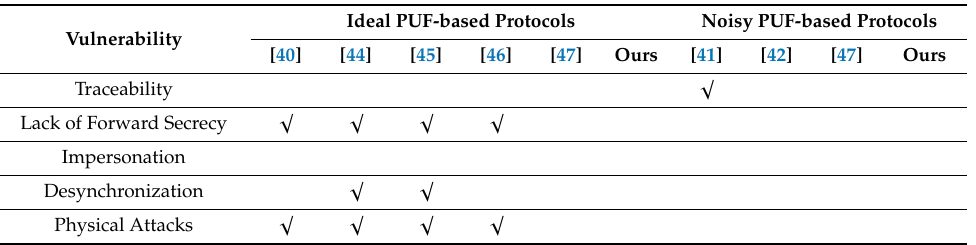
Table 3. Security performance